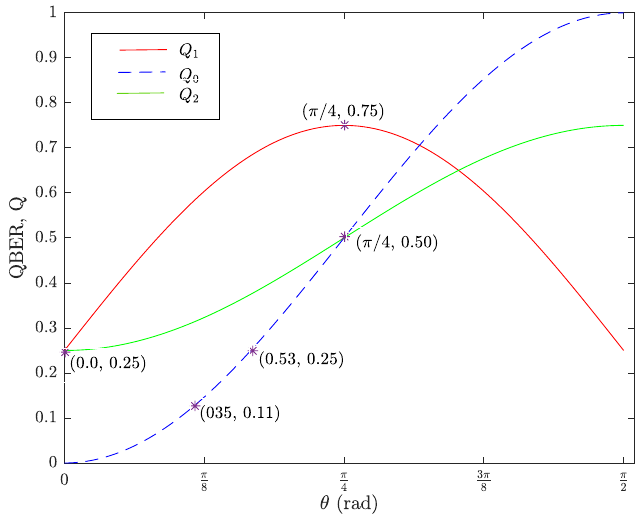
Figure 2. Comparison of the variation of the quantum bit error rate Q with the rotation angle θ for the case where there is no eavesdropping ( Q 0 ), the case where the eavesdropper performs the attack outlined in the strategy shown in Figure 1a ( Q 1 ), and the case where the eavesdropper performs the attack outlined in the strategy shown in Figure 1b ( Q 2